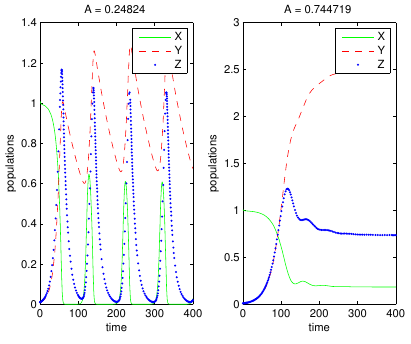
Figure 4. Parameter values: r = 0 . 56, c = 0 . 44, w = 0 . 3, s = 0 . 01, v = 0 . 7, d = 0 . 08, × 0 . 4964791610; right A = 3 B = 0 . 23: left A = 1 2